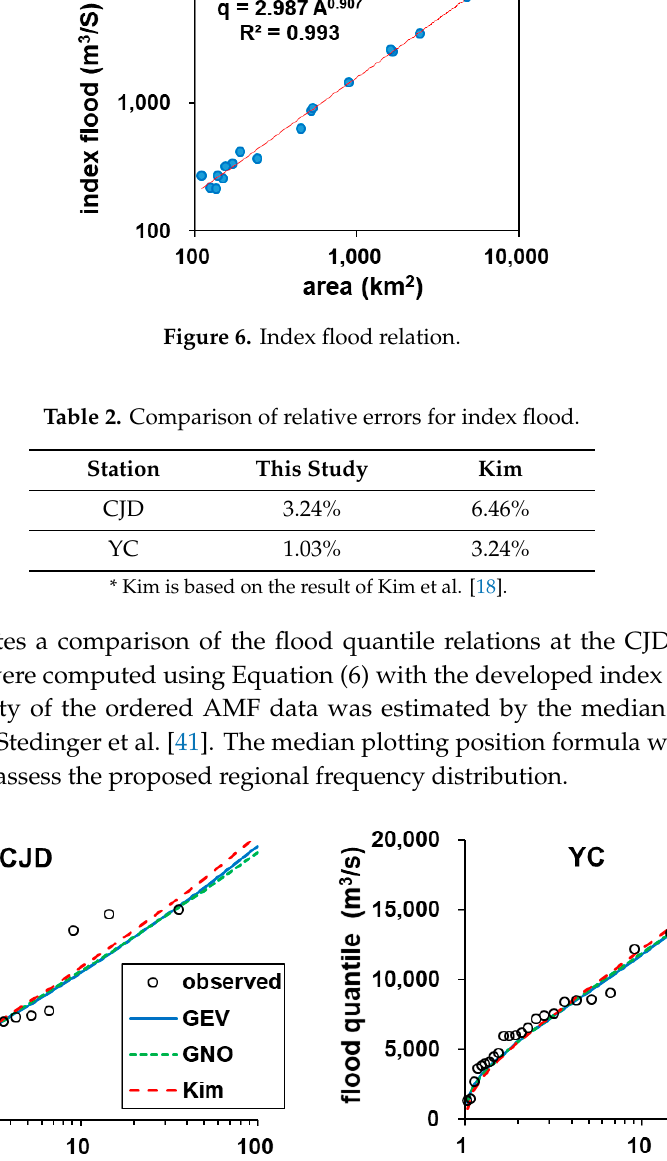
Table 3. CE and RMSNE statistic for the estimation of flood quantile.